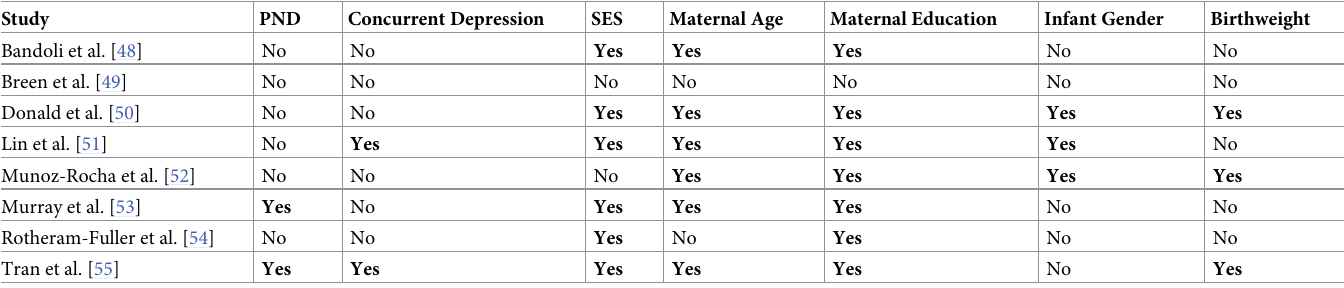
Table 2. Key a priori adjustment variables identified for antenatal